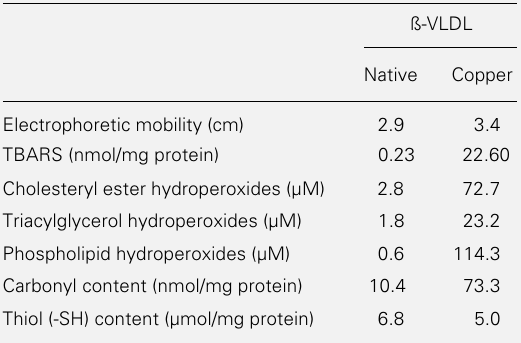
Table 1 - Biochemical determinations of native and copper- oxidized